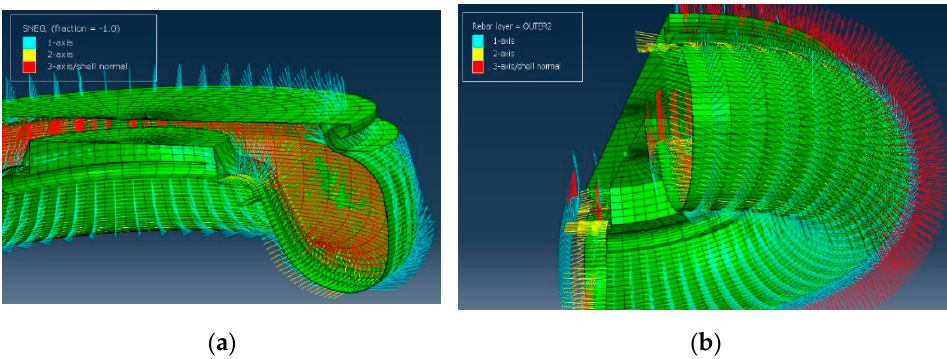
Figure 10. Rebar element direction (vector of sky-blue color) in the shell element: ( a ) setup with angle of 0 degree; ( b ) setup with variable ply angles.